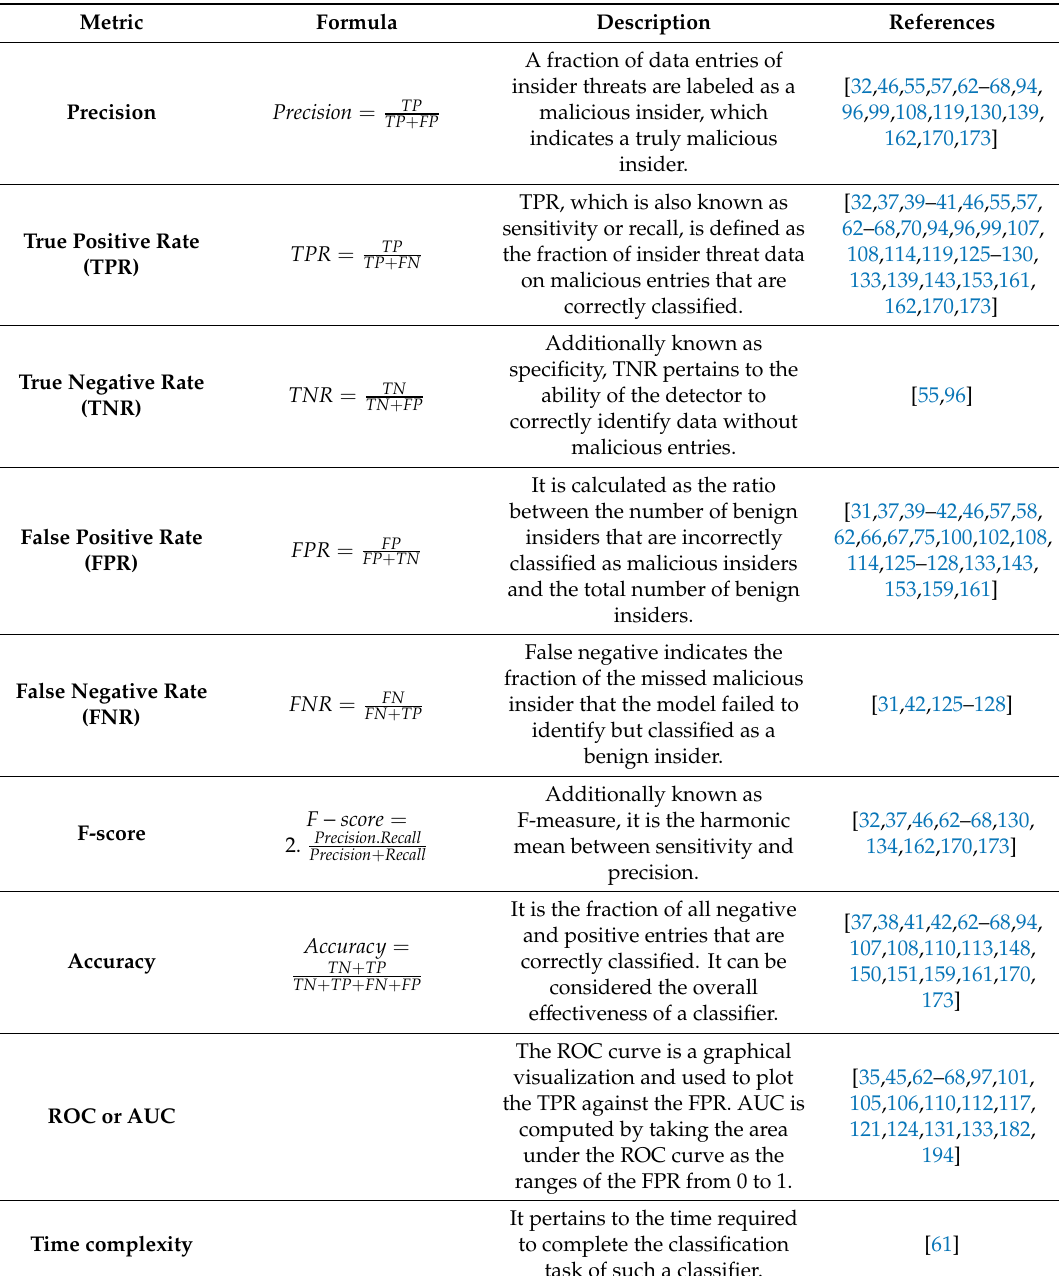
Table 3. Evaluation